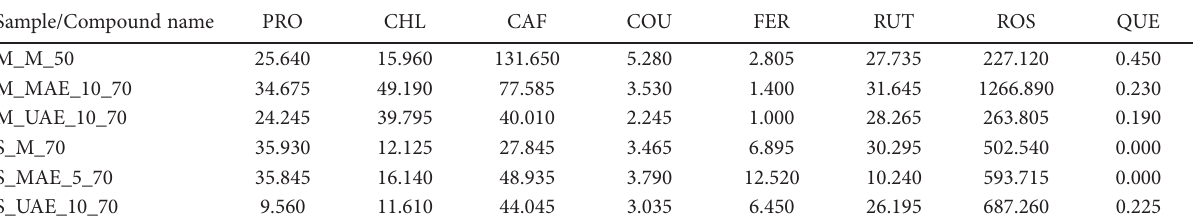
Table 4. The amount of natural compounds (µg/mL) obtained from M. officinalis and S. officinalis by the three extraction techniques. Sample/Compound